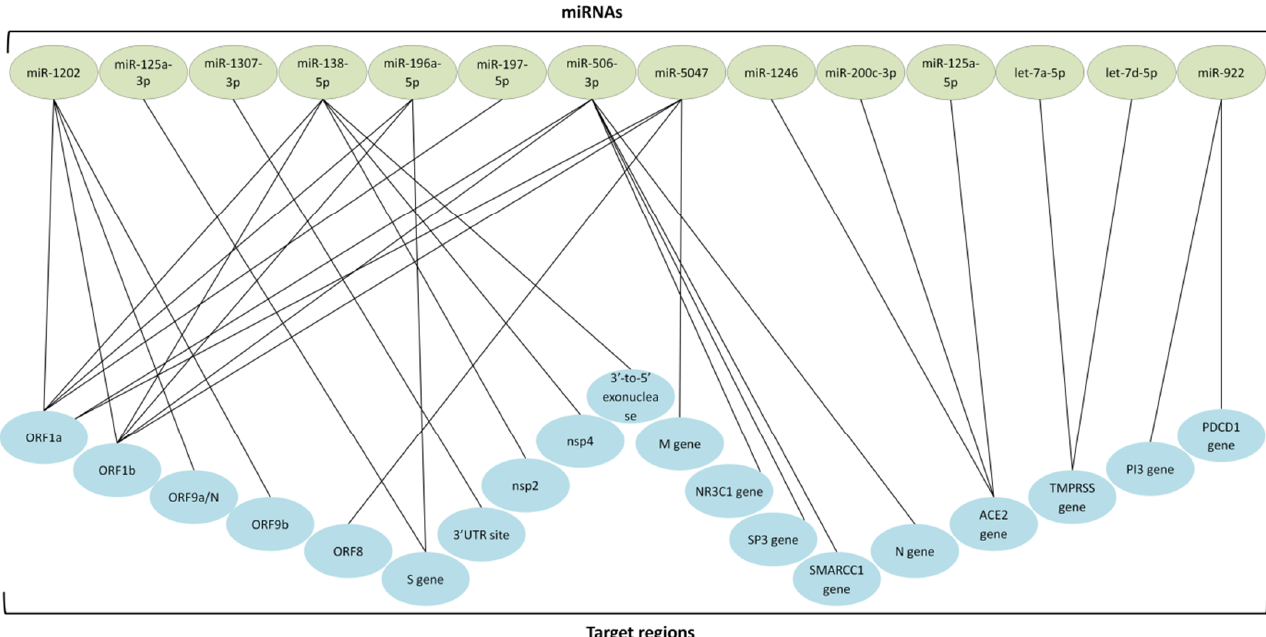
Figure 4. Targeting the SARS-CoV-2 genome via several host miRNAs. Abbreviation: UTR, un- translated region; ORF, open reading frame; S gene, spike gene; nsp, nonstructural protein; M gene, transmembrane gene, NR3C1, glucocorticoid receptor gene; SMARCC1, SWI/SNF related, matrix associated, actin dependent regulator of chromatin subfamily C member 1; N gene, nucleocapsid gene; ACE2, angiotensin-converting enzyme 2; TMPRSS, transmembrane serine protease; PDCD1, programmed cell death protein 1 [153,174,183,185,189,191,193–206].